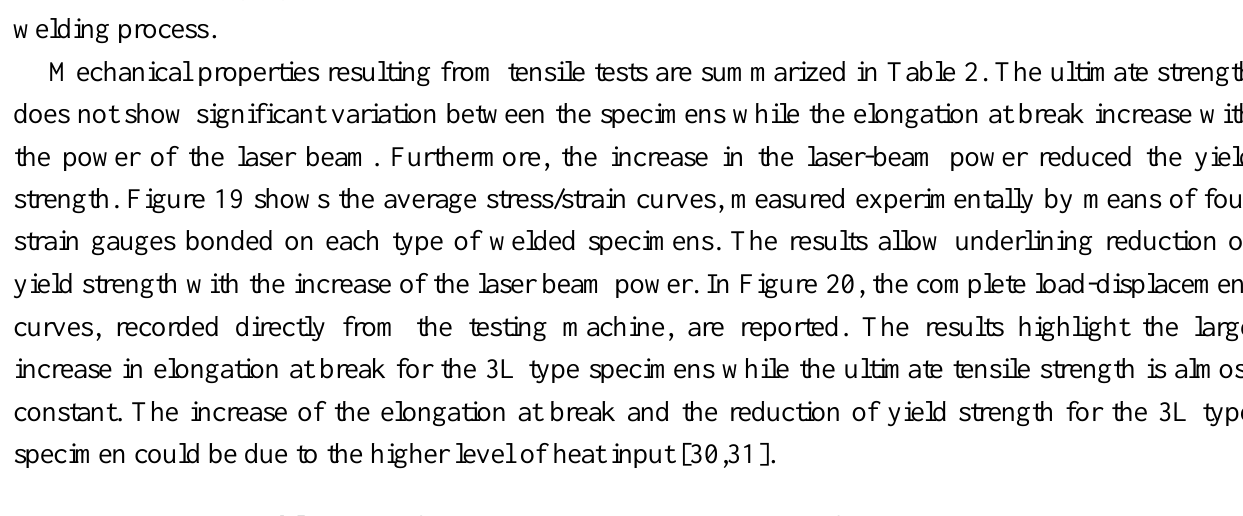
Table 2. Proof stress 0.2% and tensile strength of the